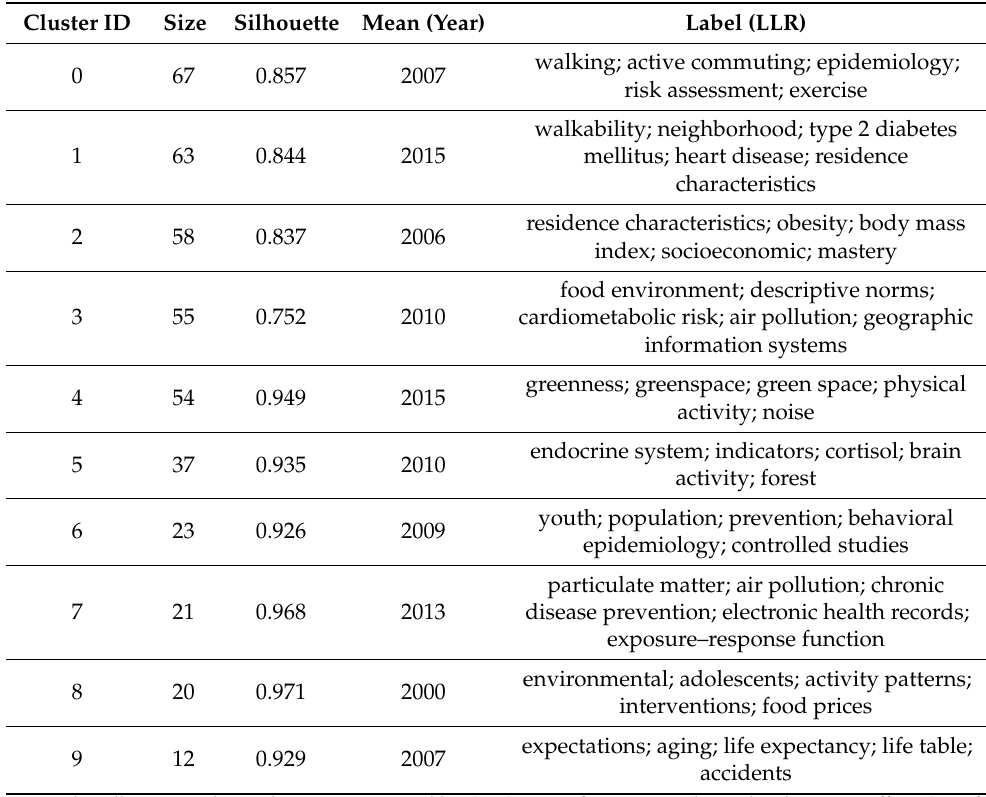
Table 7. Summary table of cluster